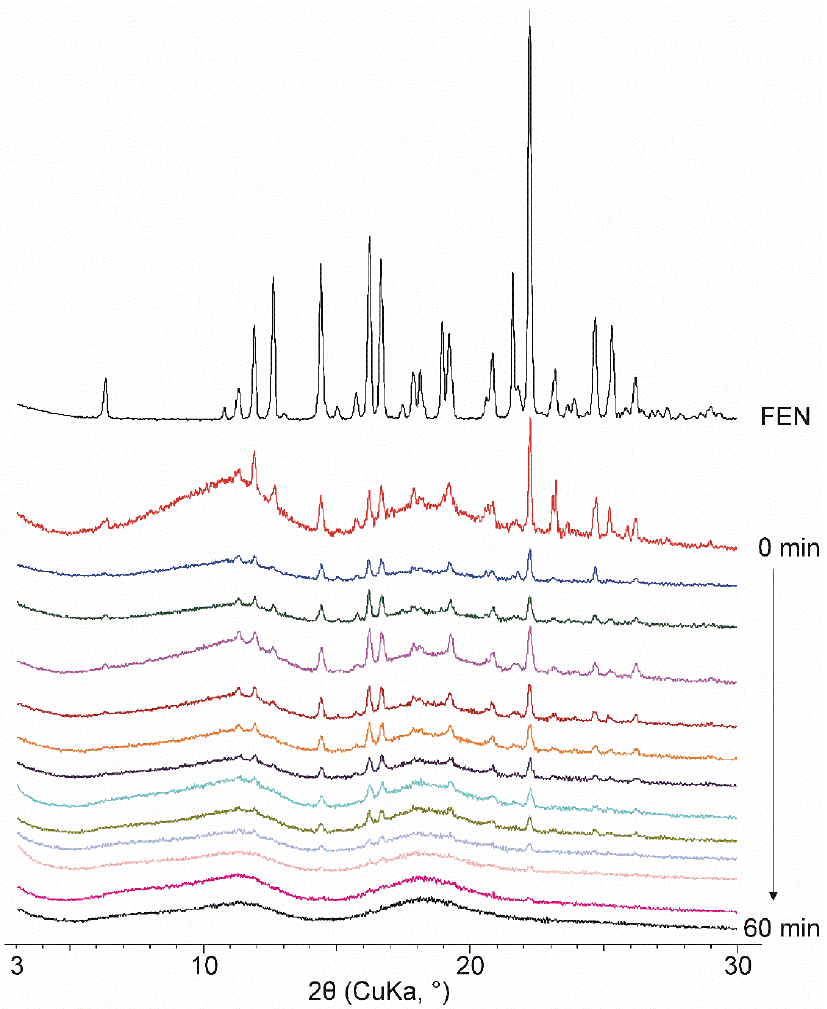
Figure 2. Diffractograms of FEN and co-ground products measured in every 5 min from 0 min to 60 min product. With the increasing grinding time, characteristic peaks decreased, and an amorphous product has been observed.